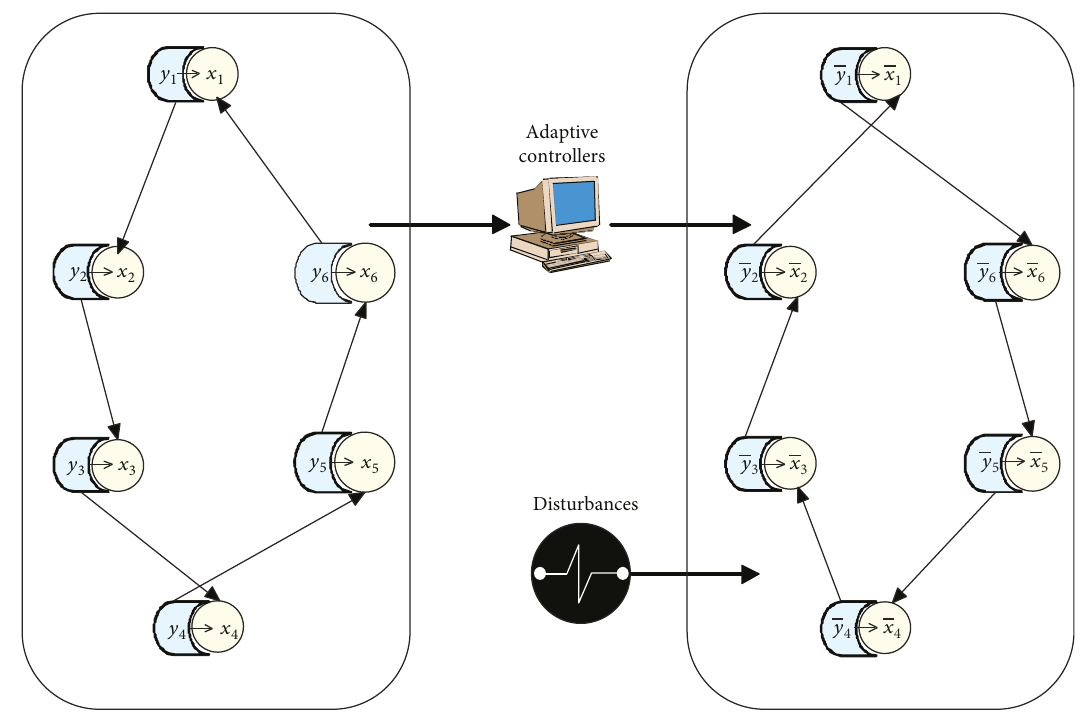
Figure 2: The topology structure of a special case of the network (4) – (7) with N = 6 .